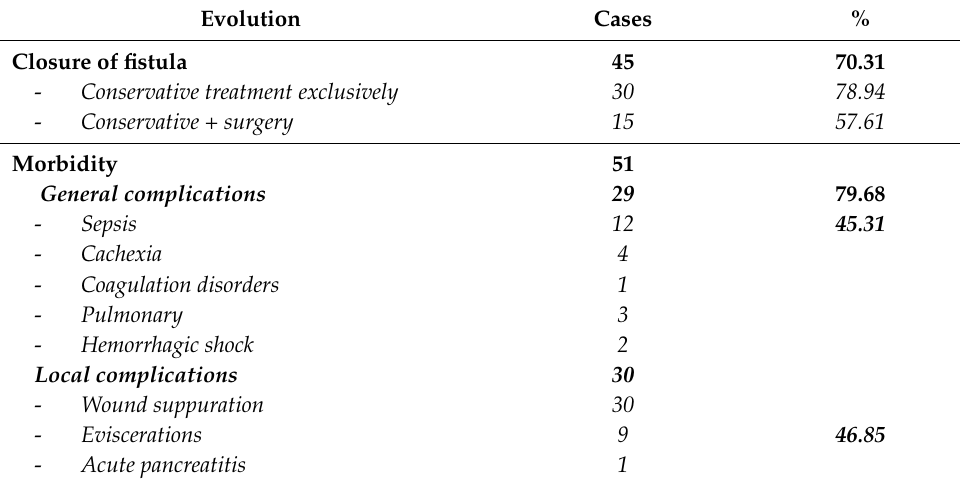
Table 4. Results: evolution, morbidity,